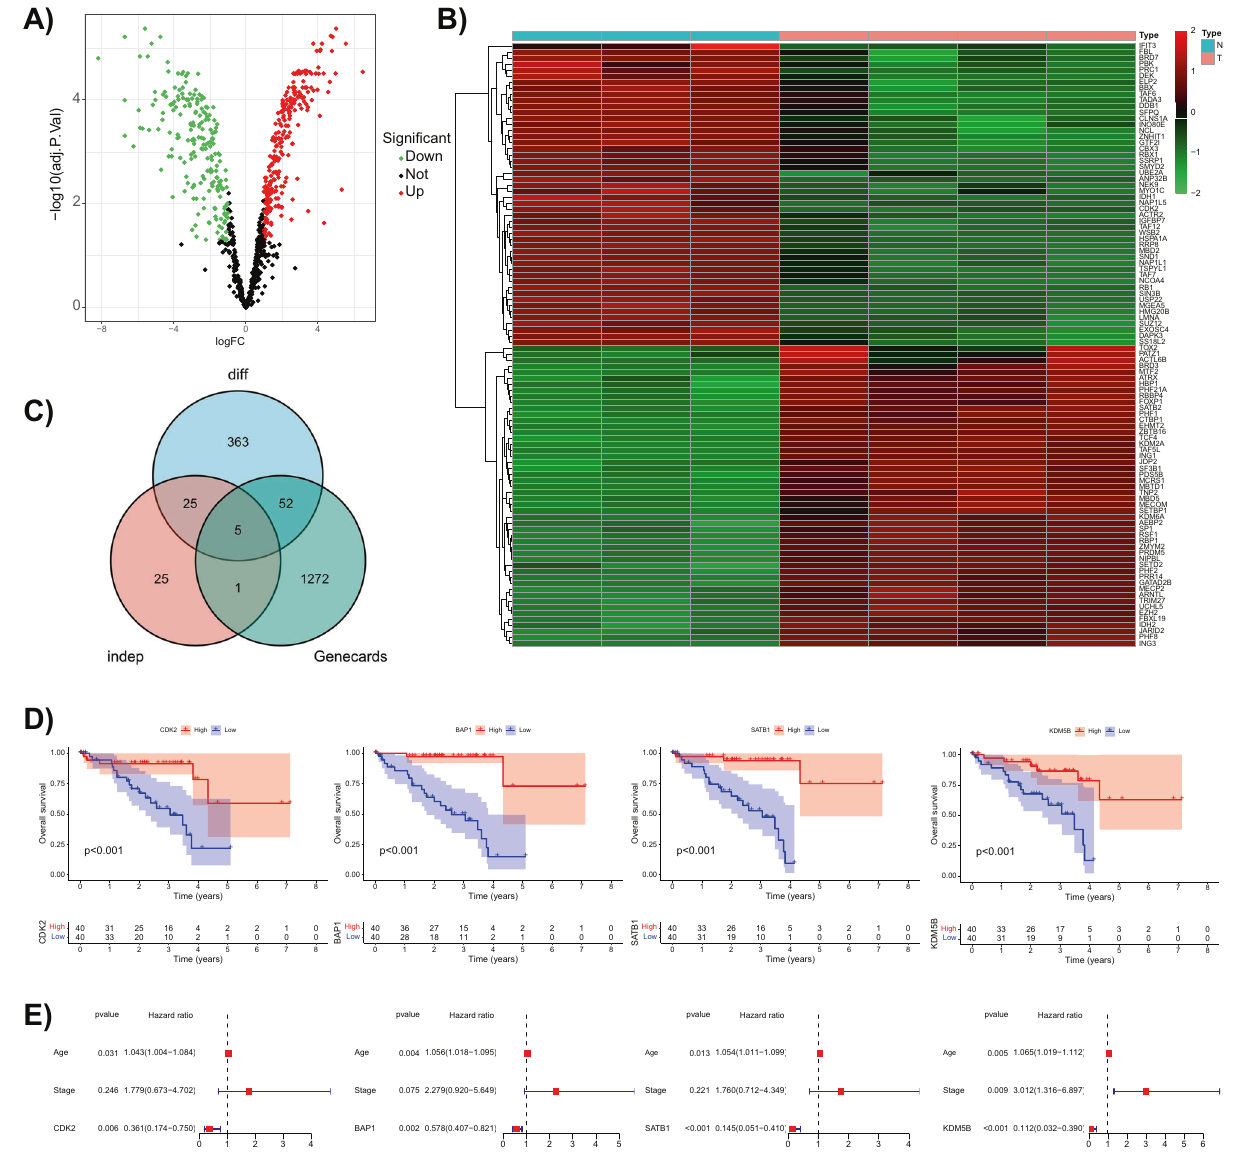
Fig. 1 Bioinformatics analysis of target genes implicated in chromatin remodeling in UVM. A Volcano plot on differential analysis of 812 chromatin regulators in the microarray dataset GSE62075 from GEO database (each point represents a gene, red indicates the signi fi cantly highly expressed genes, green indicates the signi fi cantly poorly expressed genes, and black indicates non-differentially expressed genes). B Heatmap of the difference analysis showing the expression of the 50 most signi fi cantly upregulated and downregulated genes, each column represents a single sample, each row represents a single gene, and the color means the same with panel ( A ). C Venn diagram of the intersection of the DEGs, independent prognostic factors, and UVM-related genes, revealing 5 candidate genes. D Survival analysis regarding the expression of CDK2, BAP1, SATB1, and KDM5B (the top half is a survival curve diagram, the abscissa is the survival time, the ordinate is the survival rate, red and blue curves indicate the high and low expression, respectively; p < 0.001 indicates a signi fi cant difference with regard to survival time between the two groups; the lower half indicates the number of remaining patients in the two groups at each survival time point. E The multivariate-independent prognostic analysis of CDK2, BAP1, SATB1, and KDM5B (each row represents one factor, p < 0.05 indicates that the factor is associated with survival, HR > 1 means that the point is on the right of the dotted line and represents a high risk factor, HR < 1 means that the point is on the left side of the dotted line and represents a low-risk factor). distribution in cells in response to si-RUVBL1-1 or si-RUVBL1-2 by fl ow cytometry. It was noted that cells in the G2 phase were signi fi cantly increased in the presence of si-RUVBL1-1 or si- RUVBL1-2, indicating that knockdown of RUVBL1 could arrest UVM in G2 phase (Fig. 6D). The above results signaled that RUVBL1 promoted mitosis in UVM cells by activating CTNNB1, and that knockdown of RUVBL1 inhibited CTNNB1 transcriptional activity to arrest the UVM cell cycle.